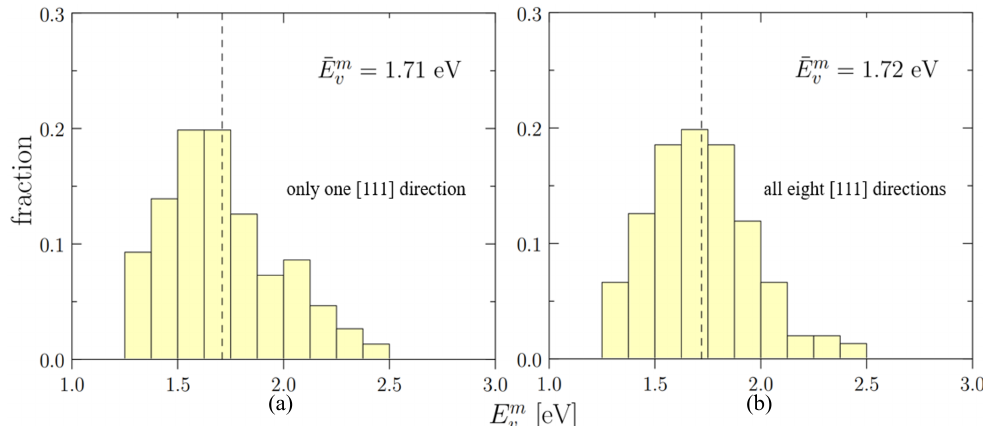
Figure 8. The distributions of vacancy migration energies when: ( a ) only one [ 111 ] direction is considered and ( b ) all eight directions of [ 111 ] type are considered. Dashed lines suggest positions of statistical averages.